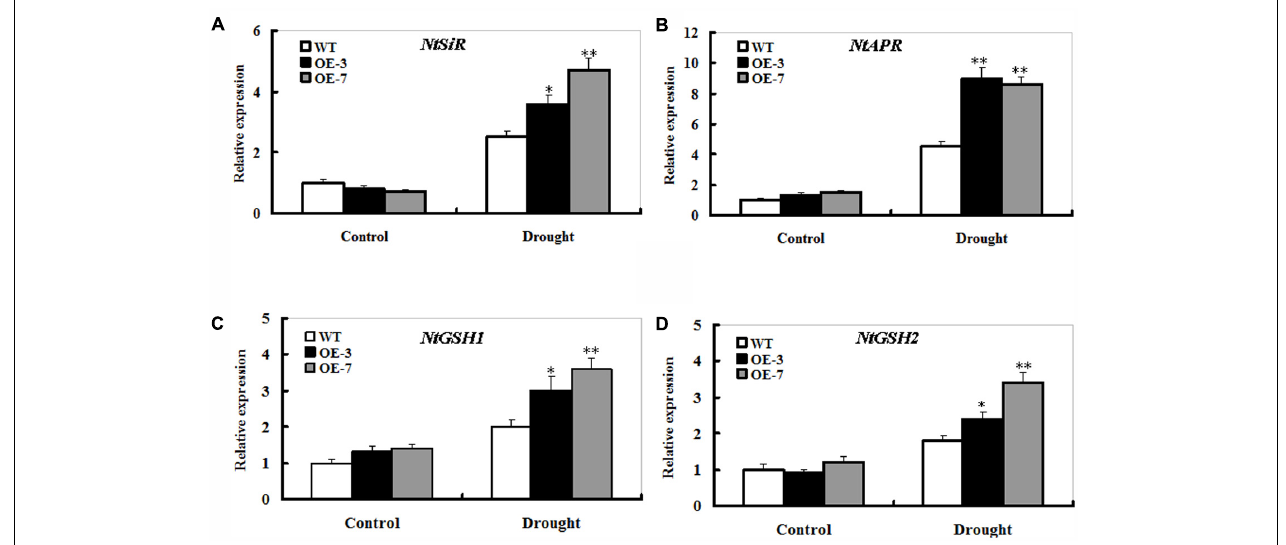
FIGURE 7 | Effect of ZmSO -overexpression on transcript levels of the S metabolism-related genes under drought stress. Leaf samples from 9 days of well-watering and drought stress, and transcriptional expression of NtSiR (A) , NtAPR (B) , NtGSH1 (C) , and NtGSH2 (D) was detected by qPCR. mRNA levels of these genes were normalized to the transcripts of Actin2 in the same samples. For each assay, the expression level of WT under control conditions was taken as 1.0, and data represented mean ± SE of three biological replicates. ∗∗ t -test, with P < 0.01; ∗ t -test, with P <